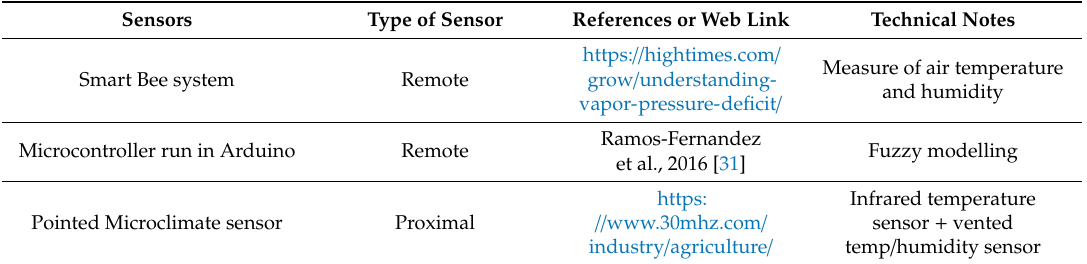
Table 1. Climate remote sensors for environment measuring of